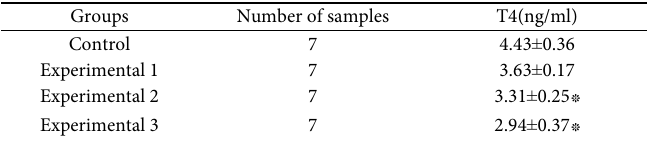
Table 2. Comparison of different amounts of silver-cobalt nanoparticles on mean serum concentration of T4 hormone in the tested groups.